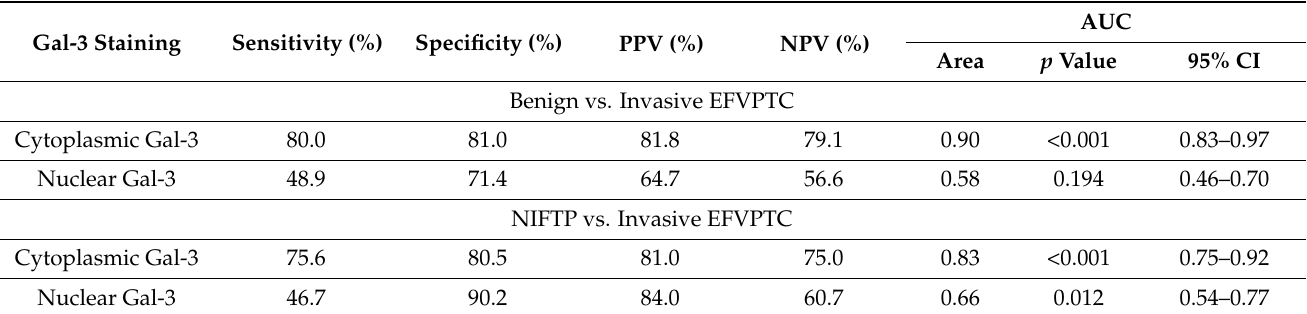
Table 5. The clinical utility of biomarkers was assessed using sensitivity, specificity, positive predictive value (PPV), negative predictive value (NPV) and area under the curve (AUC) between benign or NIFTP vs. invasive EFVPTC group. Gal-3